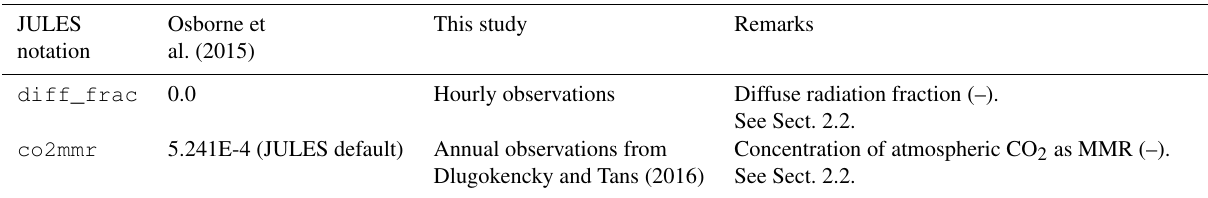
The JULES default C4 grass settings for the PAR leaf scat- tering coefficient ω PAR = 0 . 17 and the PAR leaf